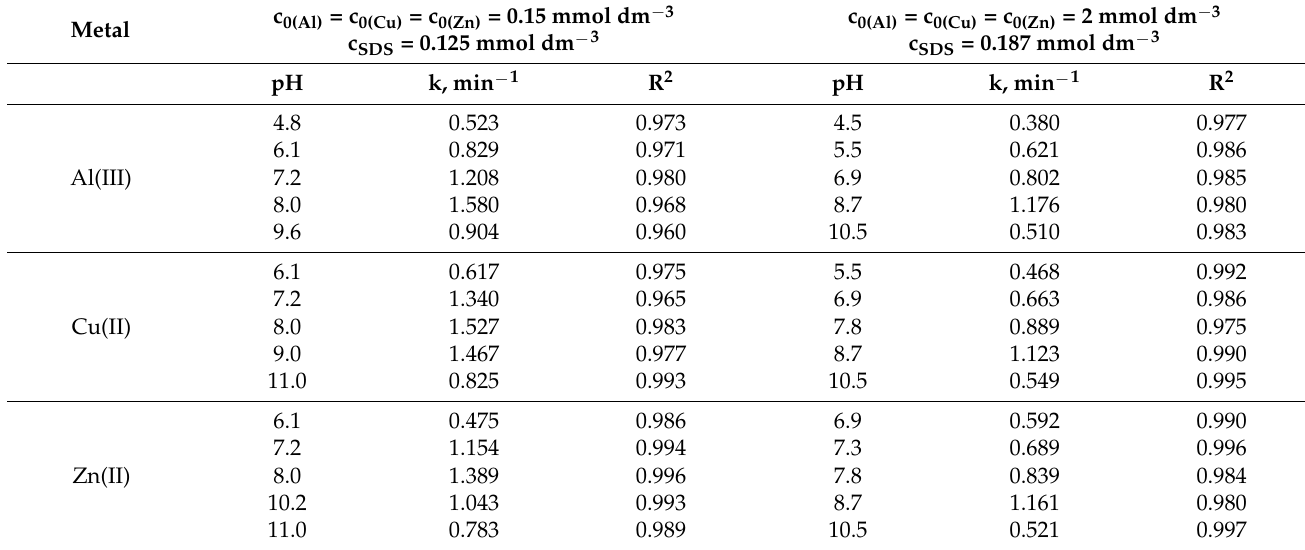
Table 3. Effect of pH on the flotation rate constants during flotation of Al(III), Cu(II), and Zn(II) mixture.